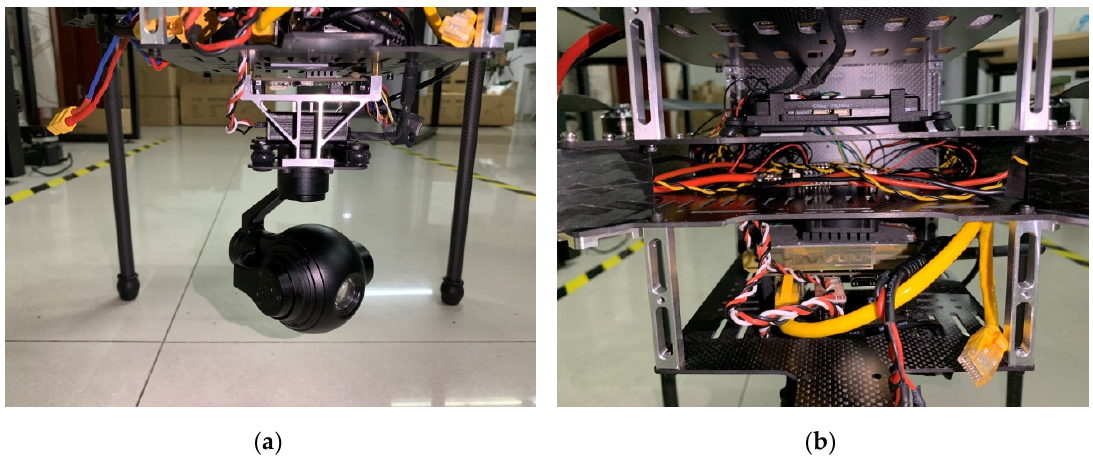
Figure 14. The customized quadrotor platform.